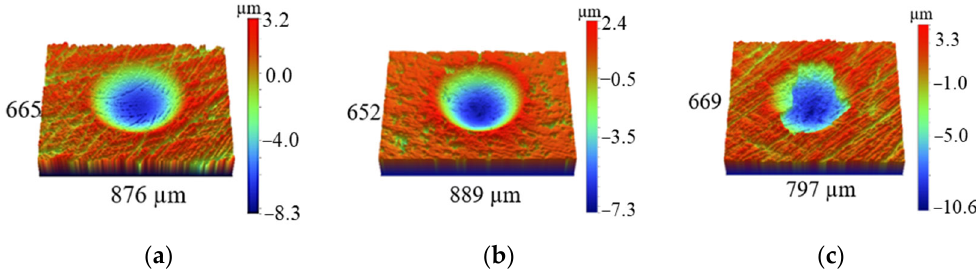
Figure 4. The 3D profiles of craters after dynamic impact tests of the Mo ‐ Zr ‐ Si ‐ B samples deposited by HIPIMS at frequencies of 10 ( a ), 50 ( b ), and 200 Hz ( c ).